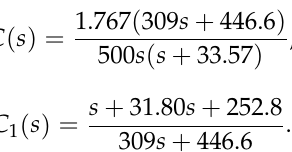
Table 1. Phase margin comparison.